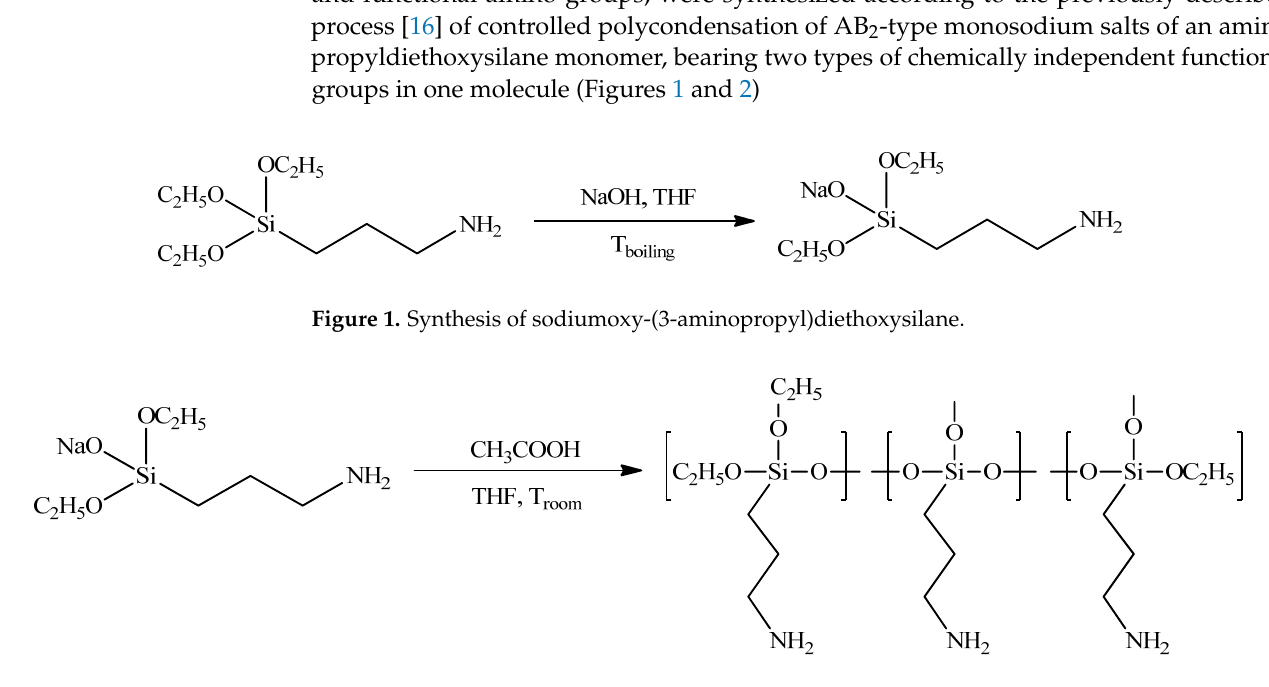
Figure 2. Synthesis of hyperbranched poly(3 ‐